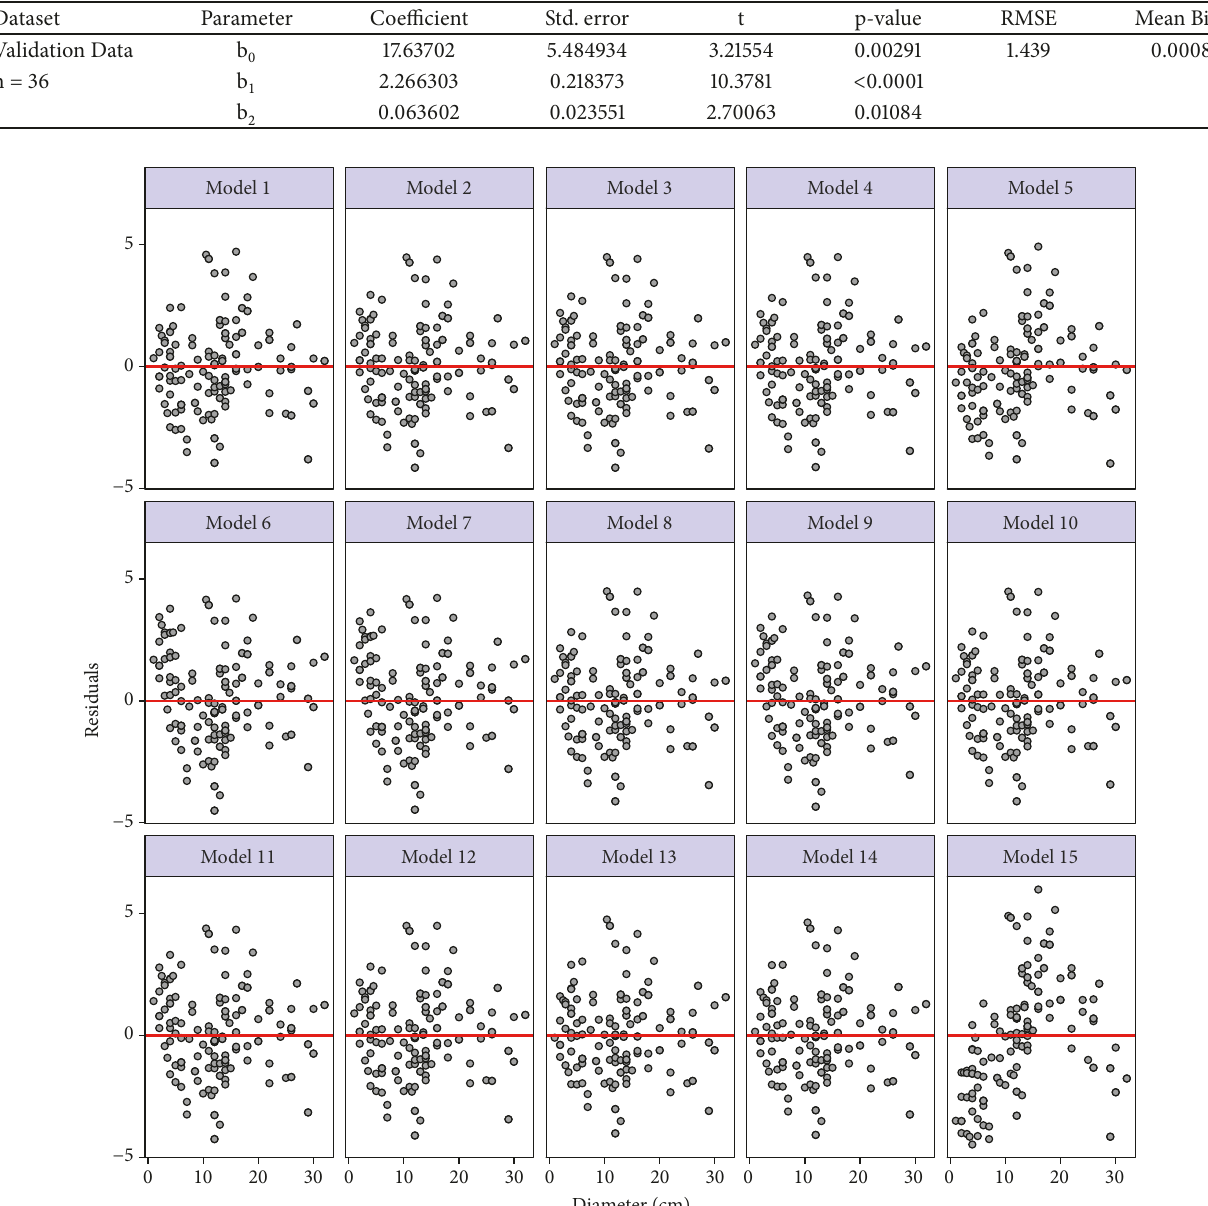
Figure 1: Residuals analysis plots of 15 H-D relationship models fitted for Cinnamomum